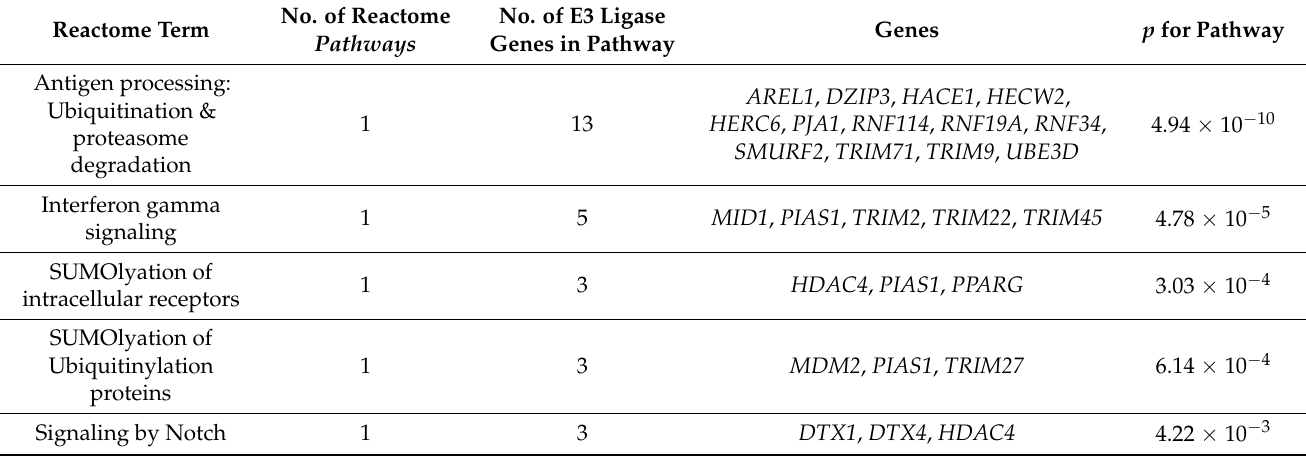
Table 4. Main Reactome pathways over-represented in list of E3 ligase genes of Figure 5.